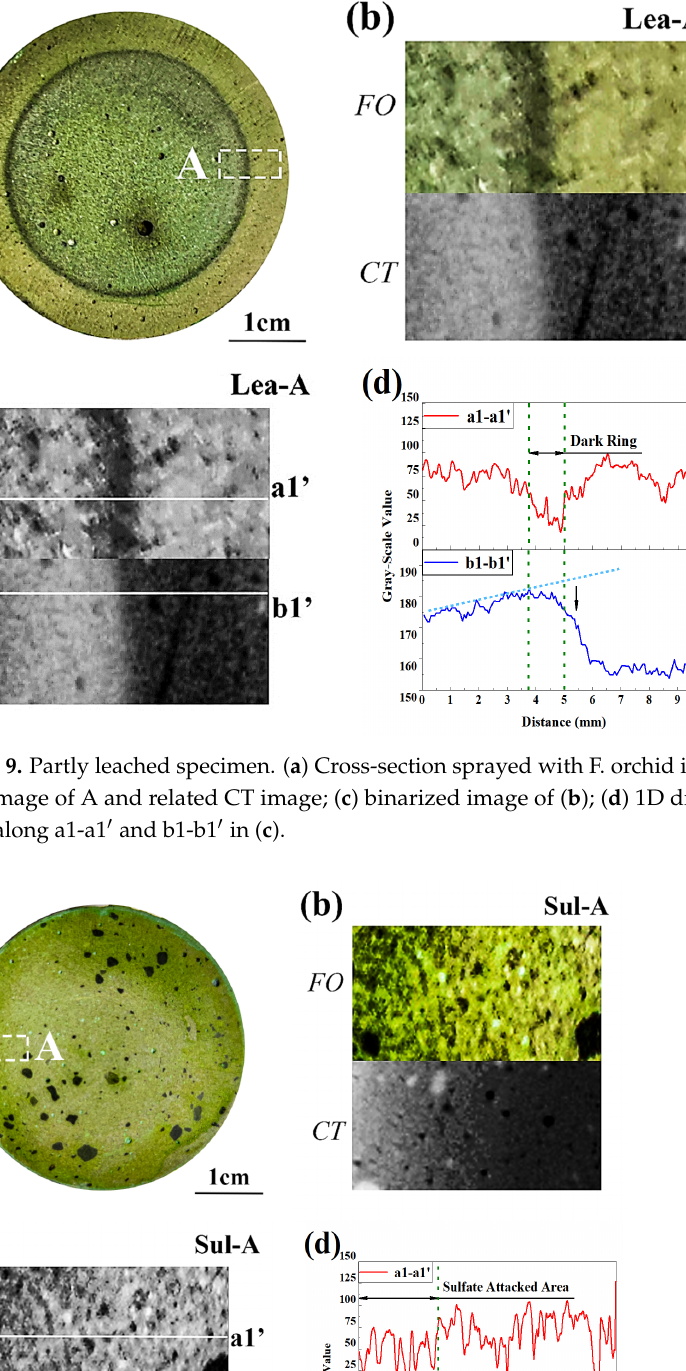
Figure 10. Partly sulfate-attacked specimen. ( a ) Cross-section sprayed with F. orchid indicator; ( b ) magnified local image of A and related CT image; ( c ) binarized image of ( b ); ( d ) 1D distribution of grayscale value along a1-a1 ′ and b1-b1 ′ in ( c ).